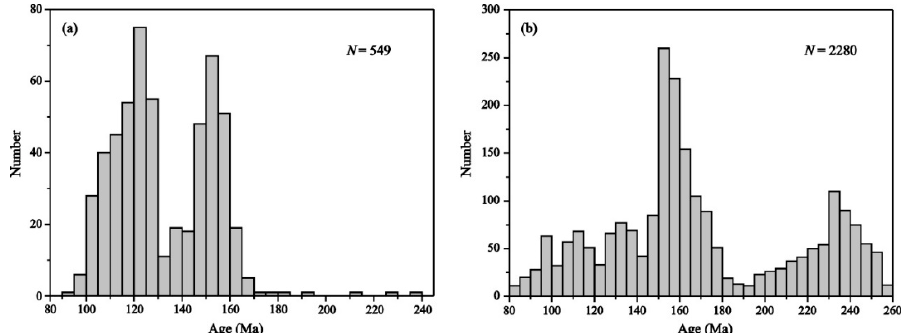
Figure 12. Histograms of zircon U ‐ Pb ages of granitoid rocks from ( a ) the SCS and from ( b ) the contiguous onshore South China continent. Data for the SCS are from the present study and a compilation of previous investigations.